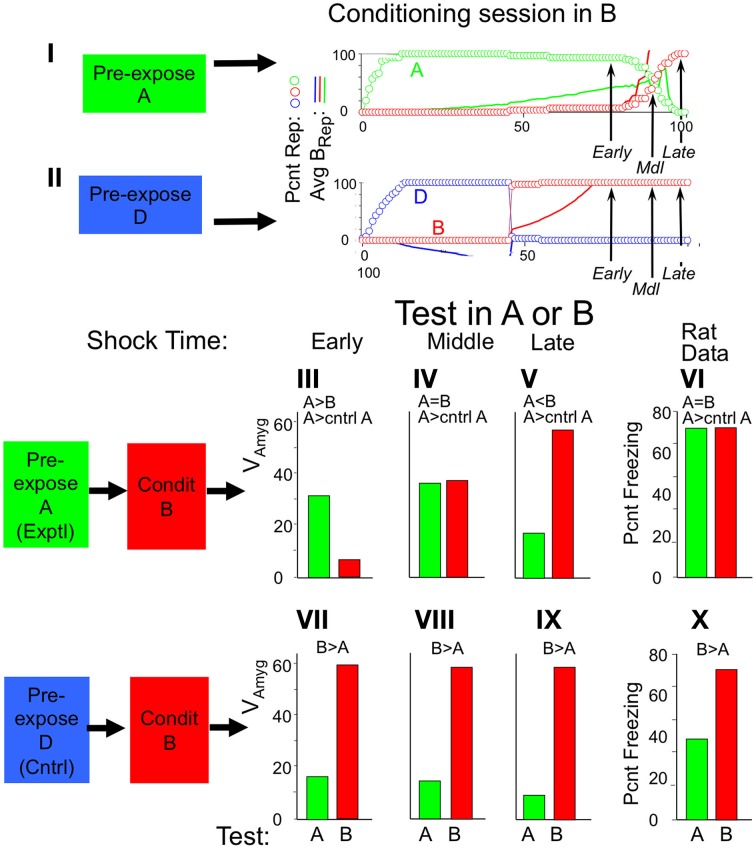
Conditioning in a novel context when a similar context is familiar. Context A and B are 95% similar; context D is maximally different from both (50% similar). (I,II). Sessions in context B after pre-exposure to either context A or D. Arrows (Early, Middle, Late) indicate when USs were given during each type of conditioning session. Circles plot percentage of runs in which the specified representation was active, and lines the mean weight of evidence for the representation (same color coding). (III–X) Average fear levels in contexts A (green bars) and B (red bars) after conditioning in B following pre-exposure to either context A or D. First 3 graphs in each row are simulation results for test following conditioning with USs at the early, middle, or late time points. Pre-exposures were always 60 samples; conditioning sessions were 75 (Early), 88 (Middle) or 95 (Late) sample long with US at end. All figures are averages for 30 simulations. (VI,X). Far-right graphs are Rudy and O'Reilly data (Rudy and O'Reilly, 1999).